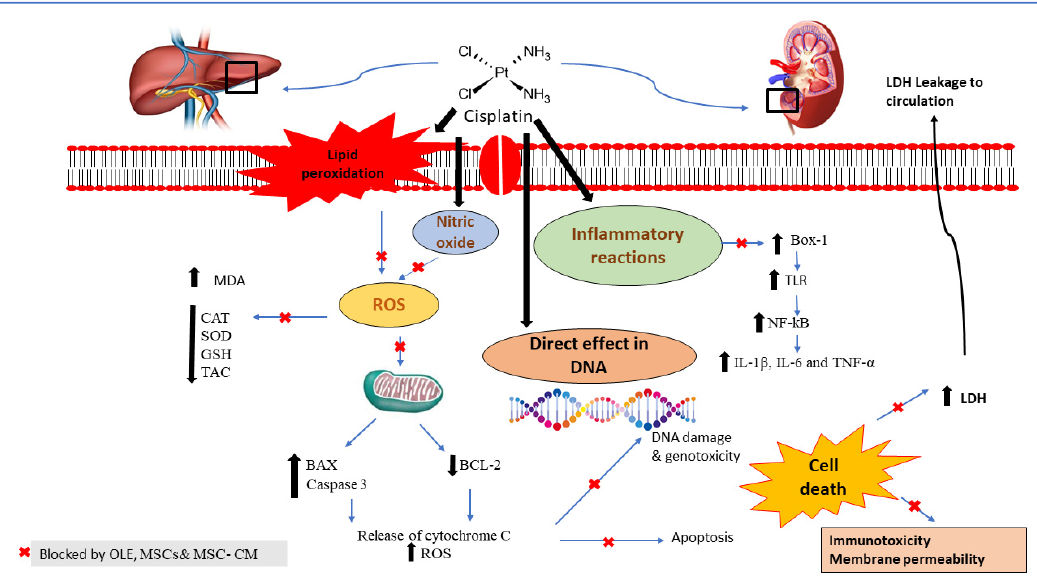
Scheme 2. A proposed schematic diagram representing the activation of ROS, inflammatory and apoptosis signaling proteins by Cis and the role of OLE, BM-MSC, and CM-MSC to intervene in